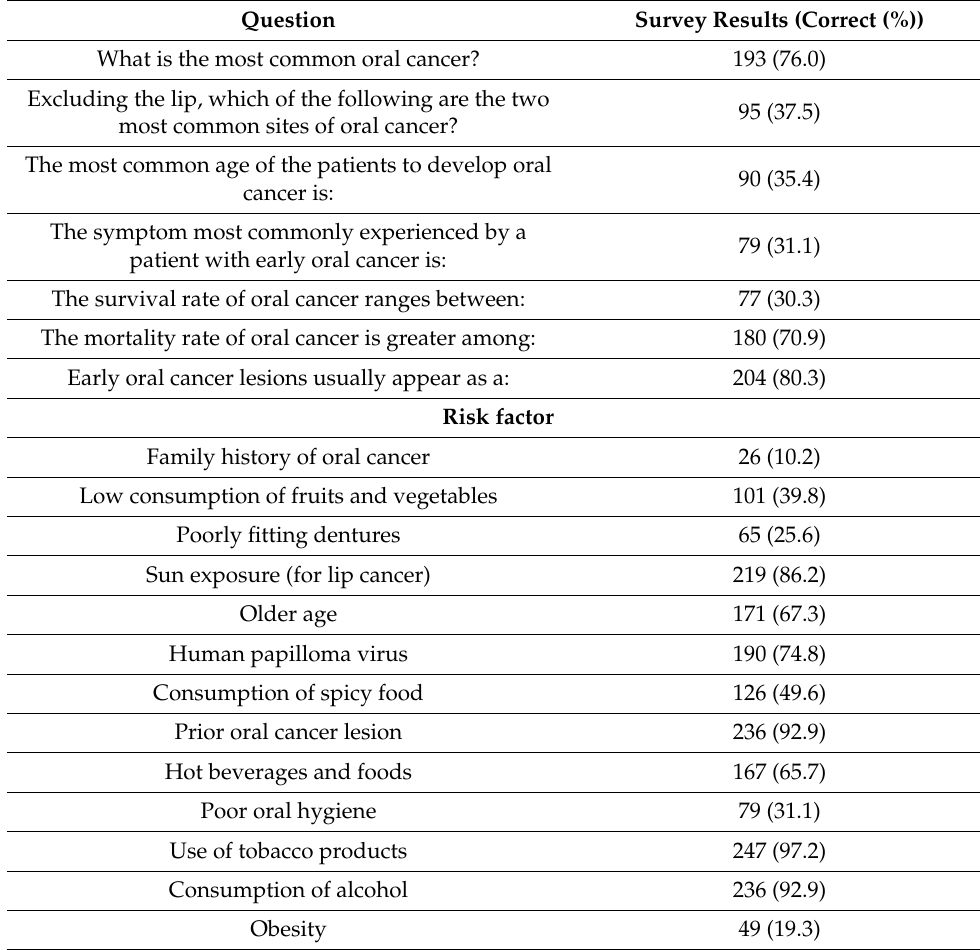
Table 2. Number and percentage of participating dentists who correctly responded to the knowledge questions and who identified high risk factors for oral cancer ( n = 254).